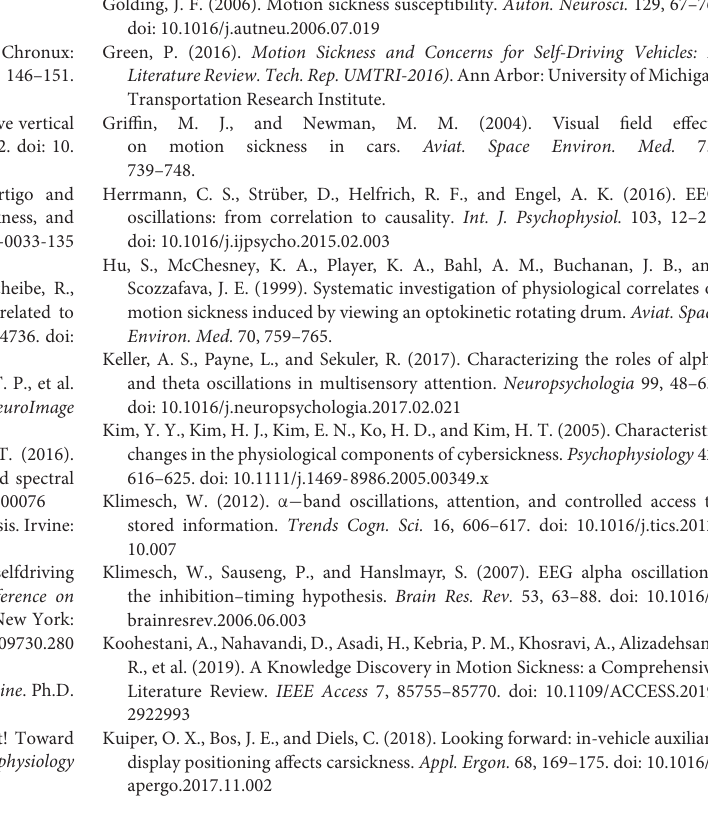
Supplementary Figure 1 | Illustration of the mean frequency power at increasing levels of motion sickness. The linear regression from the Spearman rank correlation analysis at the sample level are shown for the 4 frequency ranges: theta (4–8 Hz), alpha (8–12 Hz), beta (12–26 Hz), and gamma (26–40 Hz). R 2 are provided for the different linear